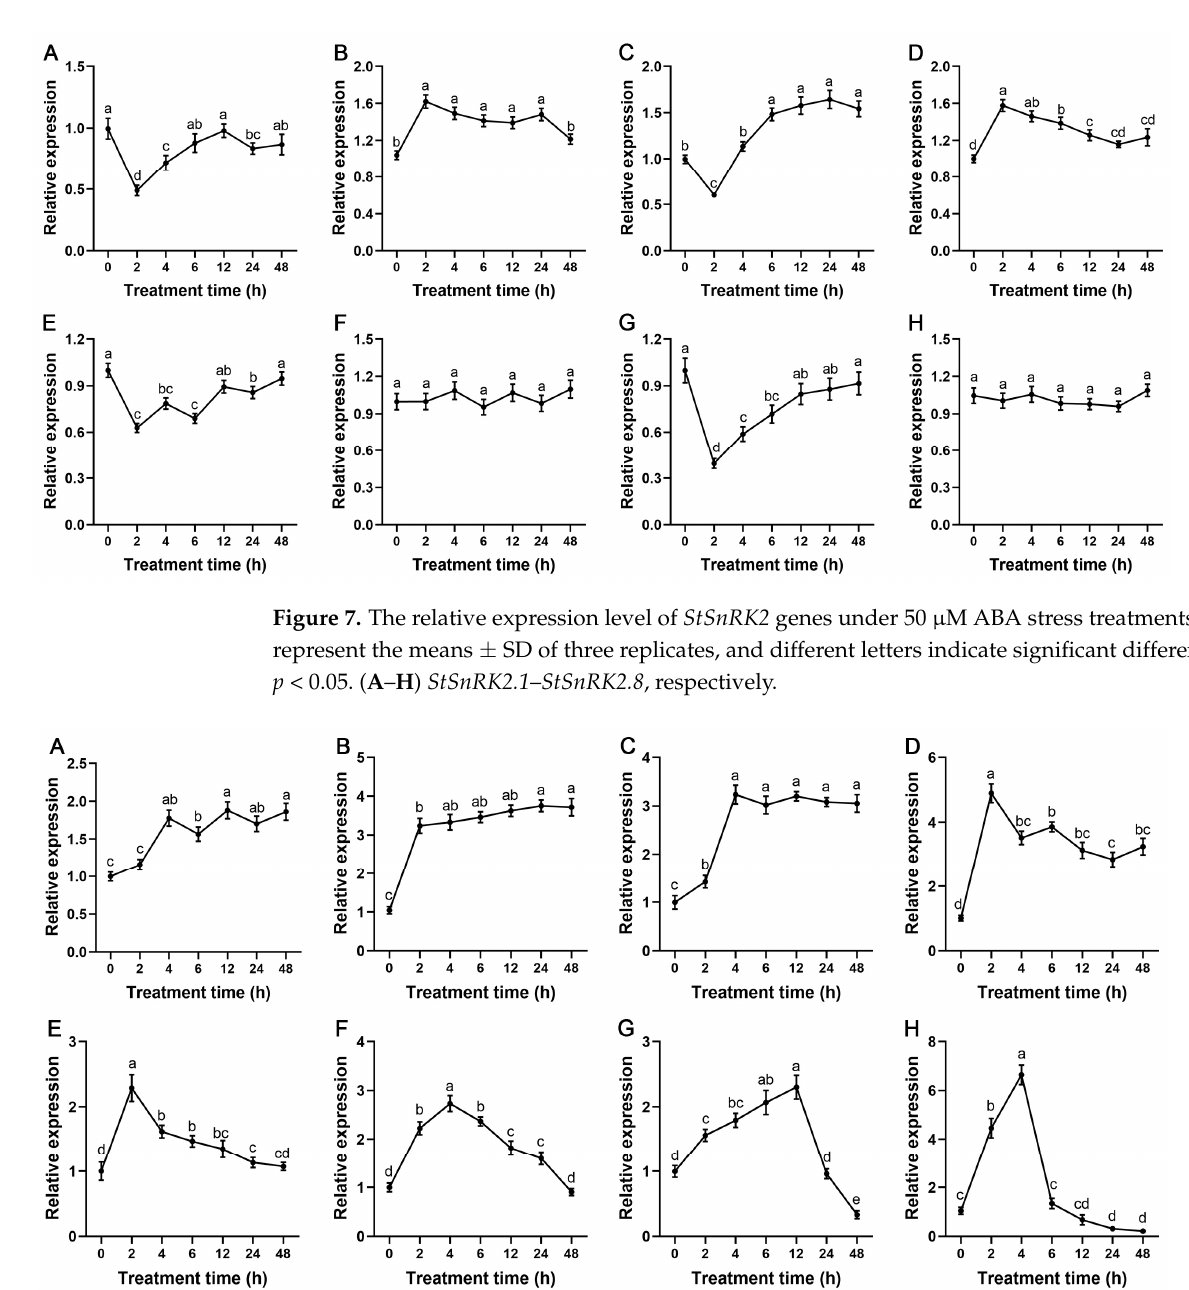
Figure 8. Relative expression level of StSnRK2 genes under 5% PEG stress treatments. Data represent the means ± SD of three replicates, and different letters indicate significant differences at p < 0.05. ( A – H ) StSnRK2.1–StSnRK2.8 , respectively.